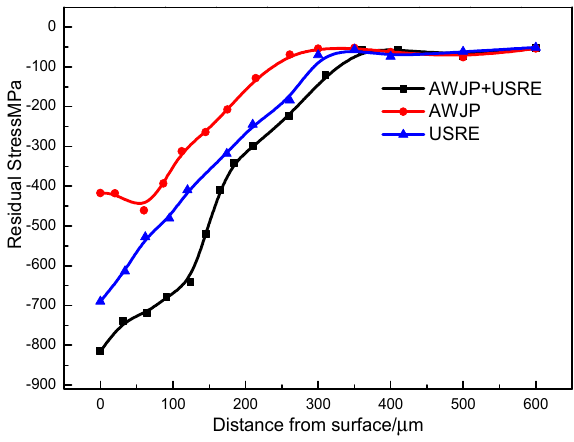
Figure 8. Variation of the residual stress along the thickness direction.